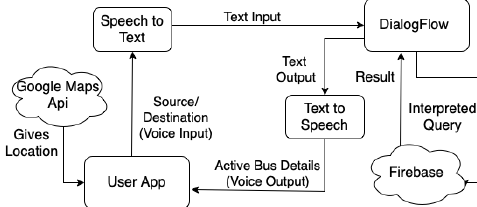
Figure 1: Functional Block Diagram of